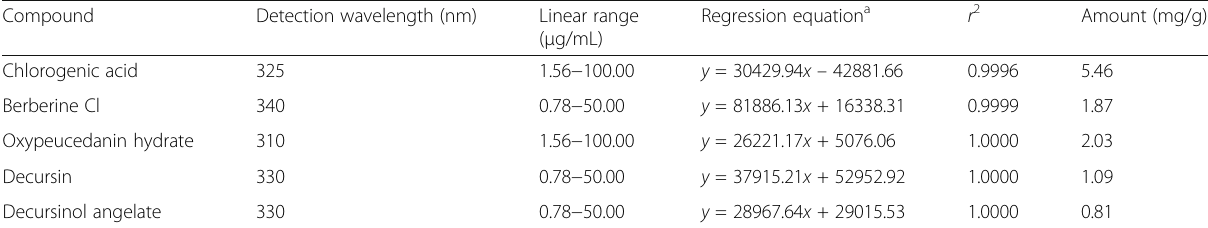
Table 3 Parameters for quantitative analysis and amount of five marker components in ChondroT sample